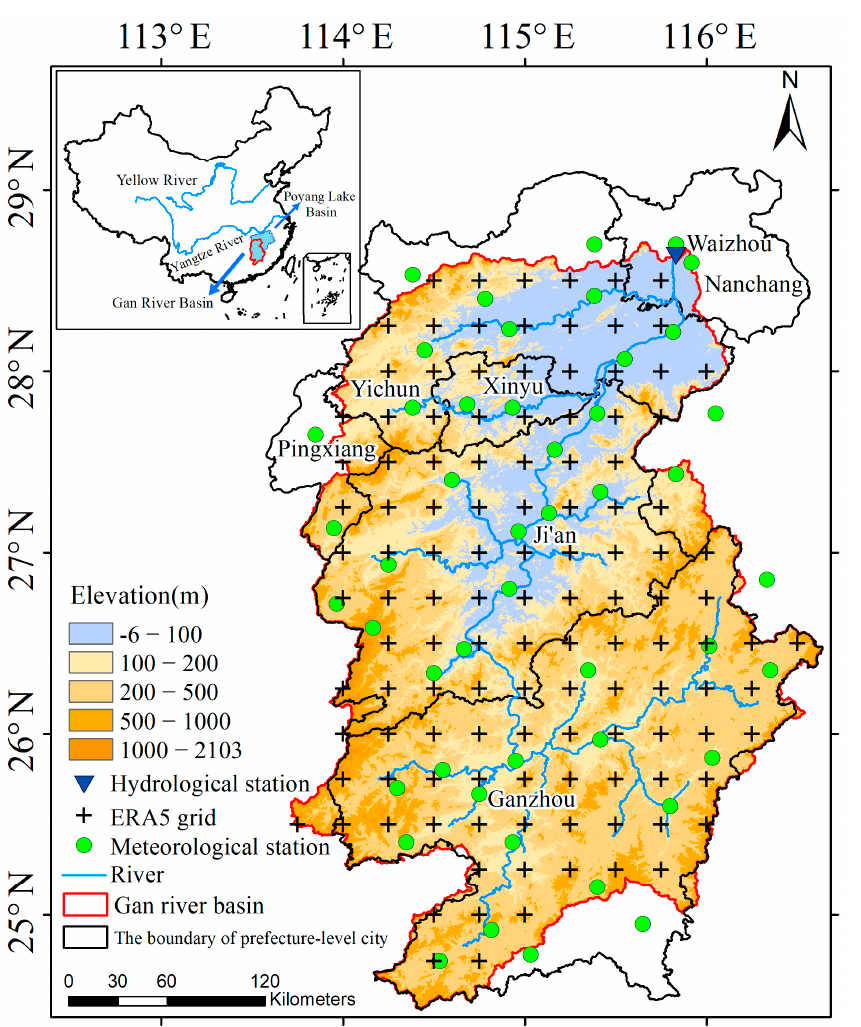
Figure 1. Location of 47 meteorological stations, one hydrological station (outlet), and 121 ERA5 grids in the GRB.